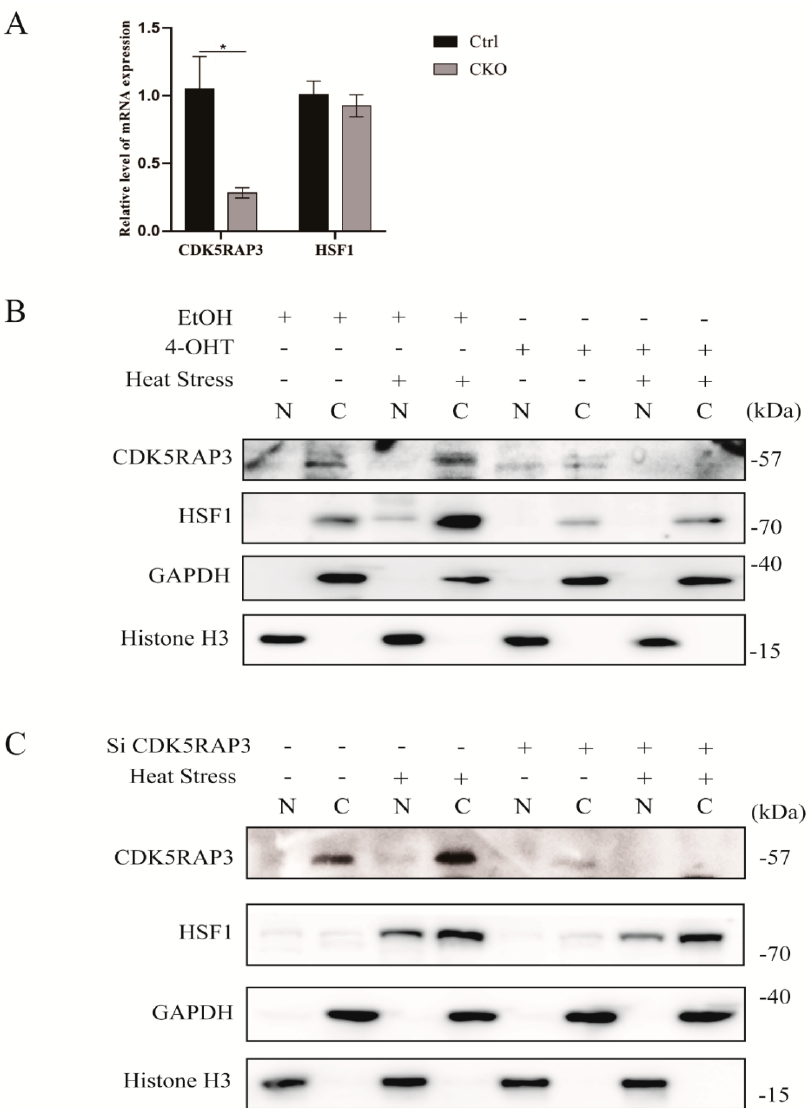
Figure 4. ( A ). The knockdown of CDK5RAP3 did not affect the mRNA expression level of HSF1, but the protein expression of HSF1. mRNA expression of HSF1(A) in mouse fibroblasts. The results are expressed as the mean ± SEM. of n = 3, * p < 0.05 compared with the control. ( B , C ). The knockout of CDK5RAP3 gene affected the nuclear and cytoplasmic distribution of HSF1. Nuclear and cytoplasmic separation experiment. CDK5RAP3mefs-control or BMECs-NC and CDK5RAP3Mefs-CKO or BMECs-SiCDK5RAP3 cells were divided into two dishes respectively, one dish was used as the control group, the other was stimulated by heat at 42 °C for 3 h as the HS group. Trypsin digested and collected the cell precipitates. C for the cytoplasm, N for the nucleus. GAPDH was cytoplasmic protein reference and Histone H3 was nuclear protein reference.